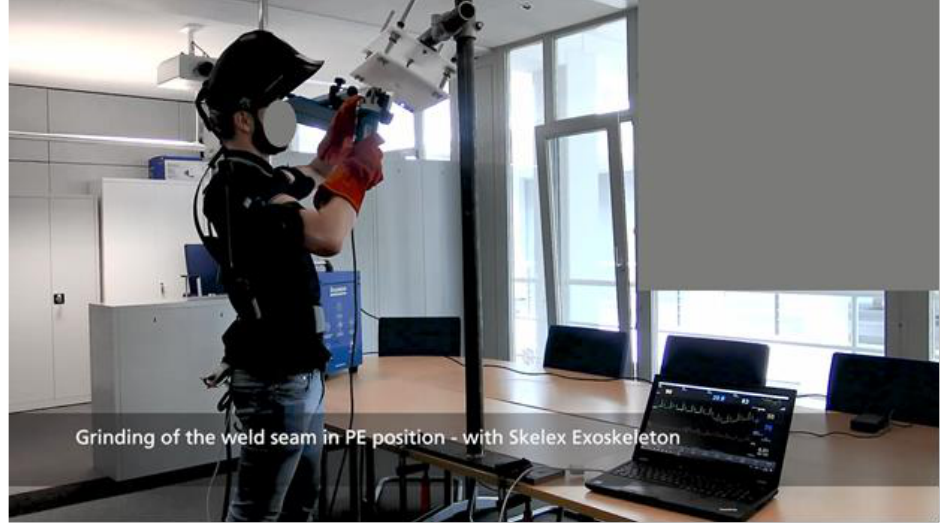
Figure 2. Exemplary illustration of the Position PE during the grinding sequence. Fraunhofer IPA.